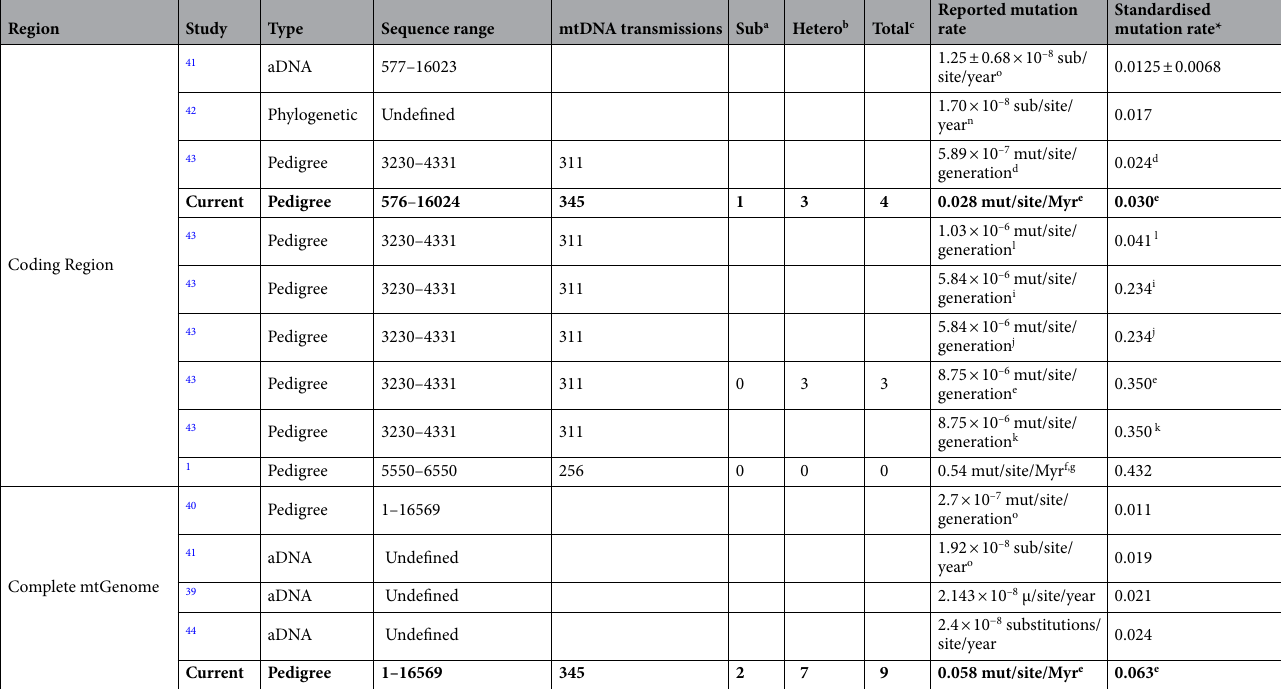
Table 3. Summary of the derived mtDNA mutation rate for various published studies. *mut/site/Myr— mutations per nucleotide per million years. Mutation rates have been adjusted for consistent comparison. One generation is25 years. Sub, substitutions; Hetero, heteroplasmic mutations; aDNA, ancient DNA. a Number of homoplasmic mutations observed. b Number of heteroplasmic mutations observed. c Total number of homoplasmic and heteroplasmic mutations observed. d Only the substitutions (including heteroplasmy) with a germinal origin present in women that would become fixed at the individual level were considered. e All the substitutions (including heteroplasmy) that were detected were considered. f Only homoplasmic mutations were considered. g One generation is 20 years. h Unclear if heteroplasmy included in rate. i Only the substitutions (including heteroplasmy) for which there was evidence of a germinal origin were considered. j Only